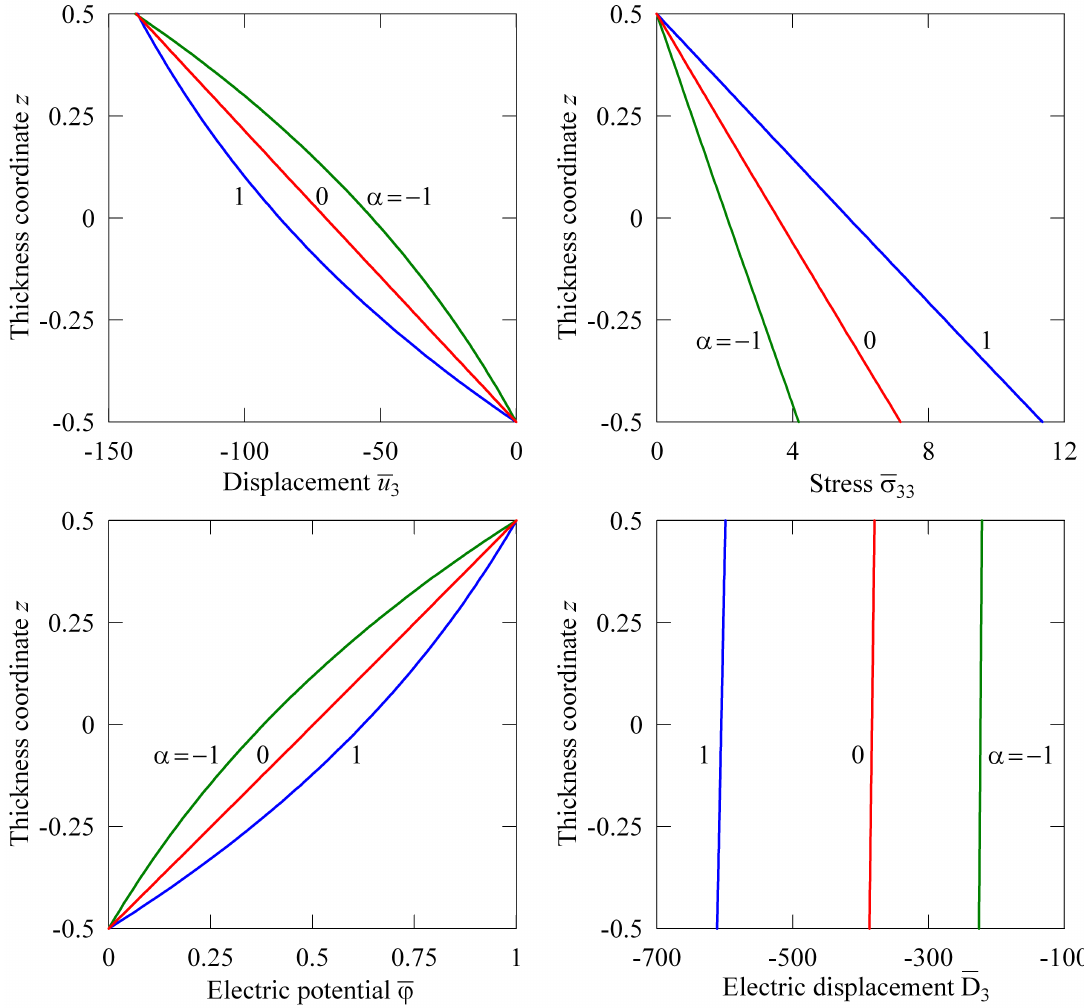
Figure 9: Through-thickness distributions of the displacement, stress, electric potential and electric displacement for a FGM piezoceramic sphere with R / h = 100 and N = 9 using 64 × 1